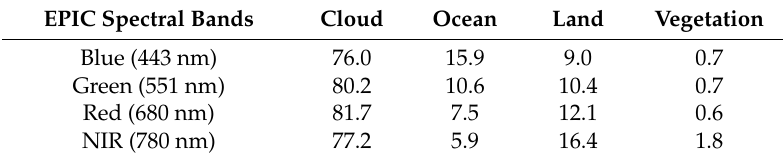
Table 4. Contribution of the Earth’s components to the annual average scattering function, %. EPIC Spectral Bands Cloud